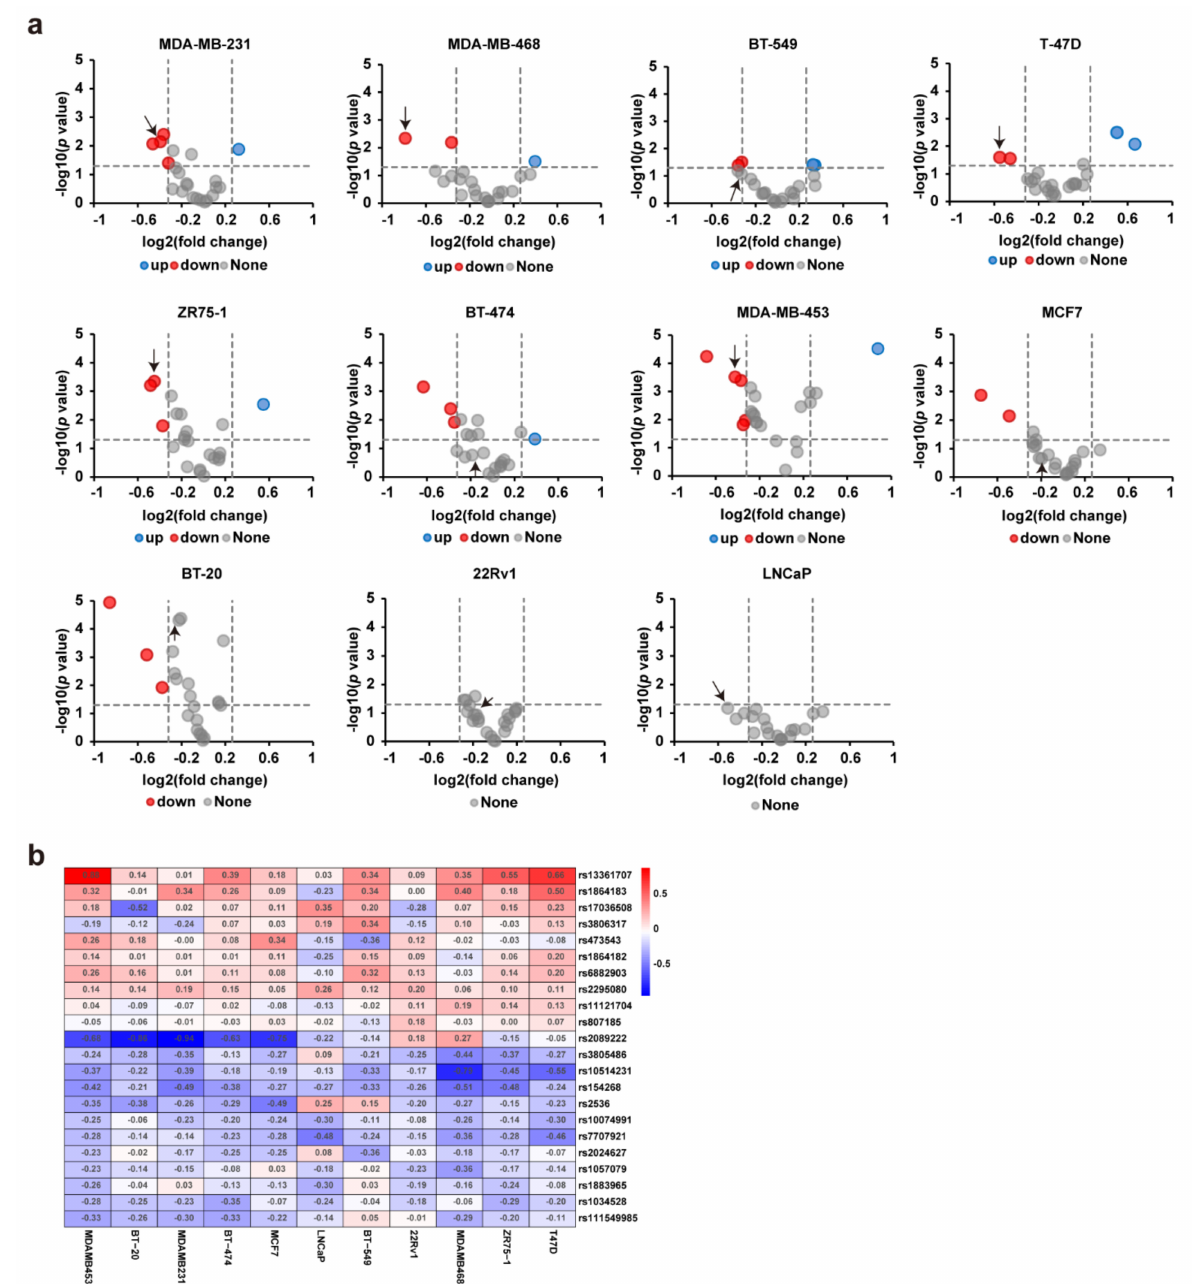
Figure 1. Parallel reporter gene assays identify multiple regulatory SNPs. ( a ) The DiR-seq reporter gene assay for the 22 risk SNPs in nine breast cancer cells and two prostate cancer cells. Red points represent SNP sites with decreased regulatory activity for the risk allele (risk/protective <0.8, p < 0.05), and blue points represent SNPs with increased activity for the risk allele (risk/protective >1.2, p < 0.05). The p values were assessed using a two-tailed Student’s t -test. The point highlighted with the arrow is rs10514231. ( b ) Heatmap showing the gene regulation activity of the 22 SNPs in breast cancer cells, annotated values are log2